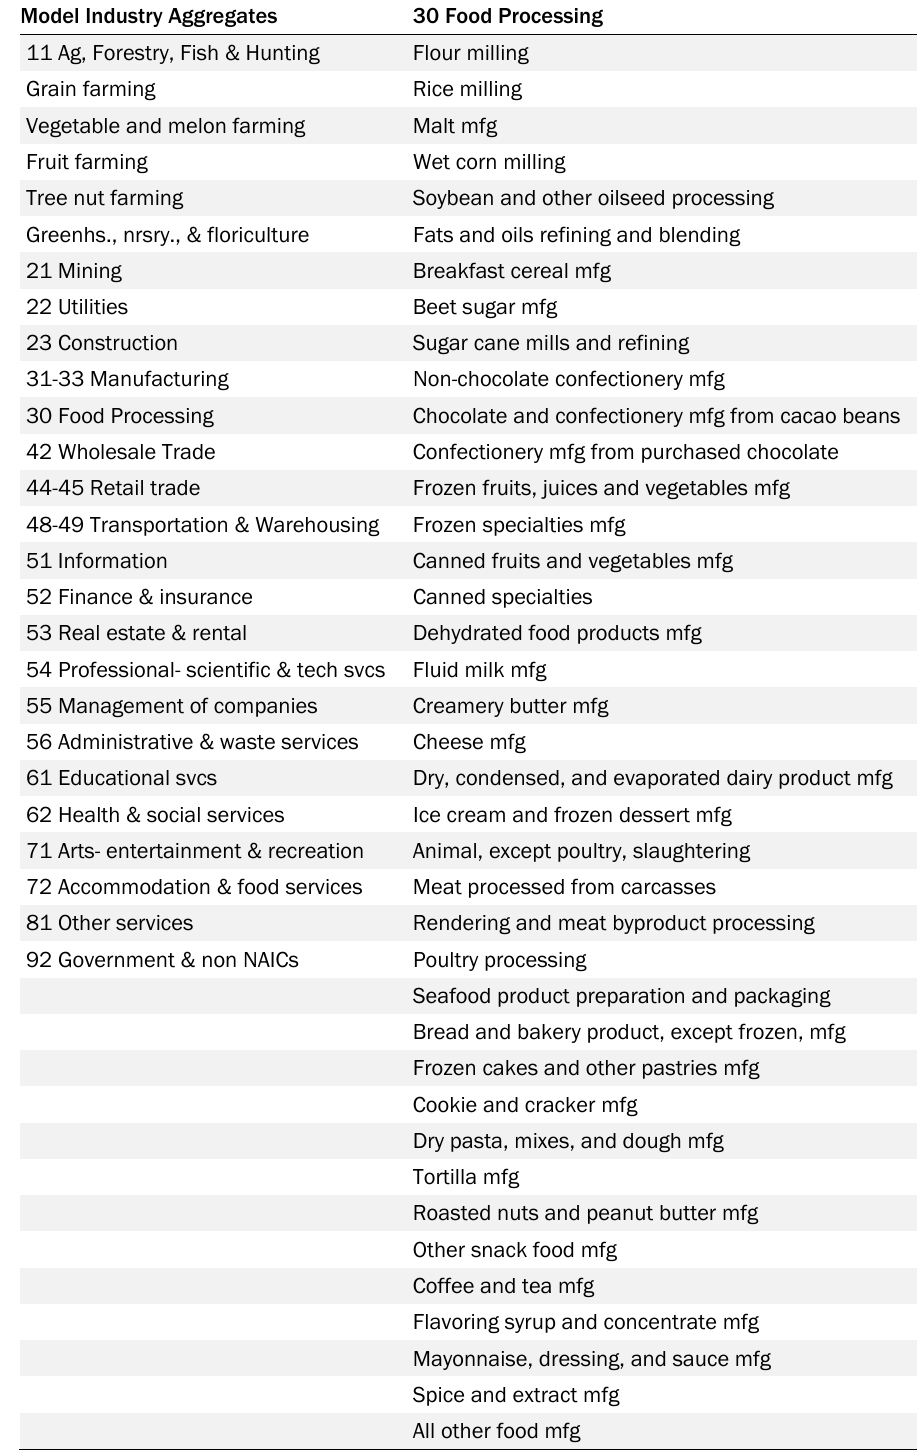
Table 1. Model Aggregates Model Industry